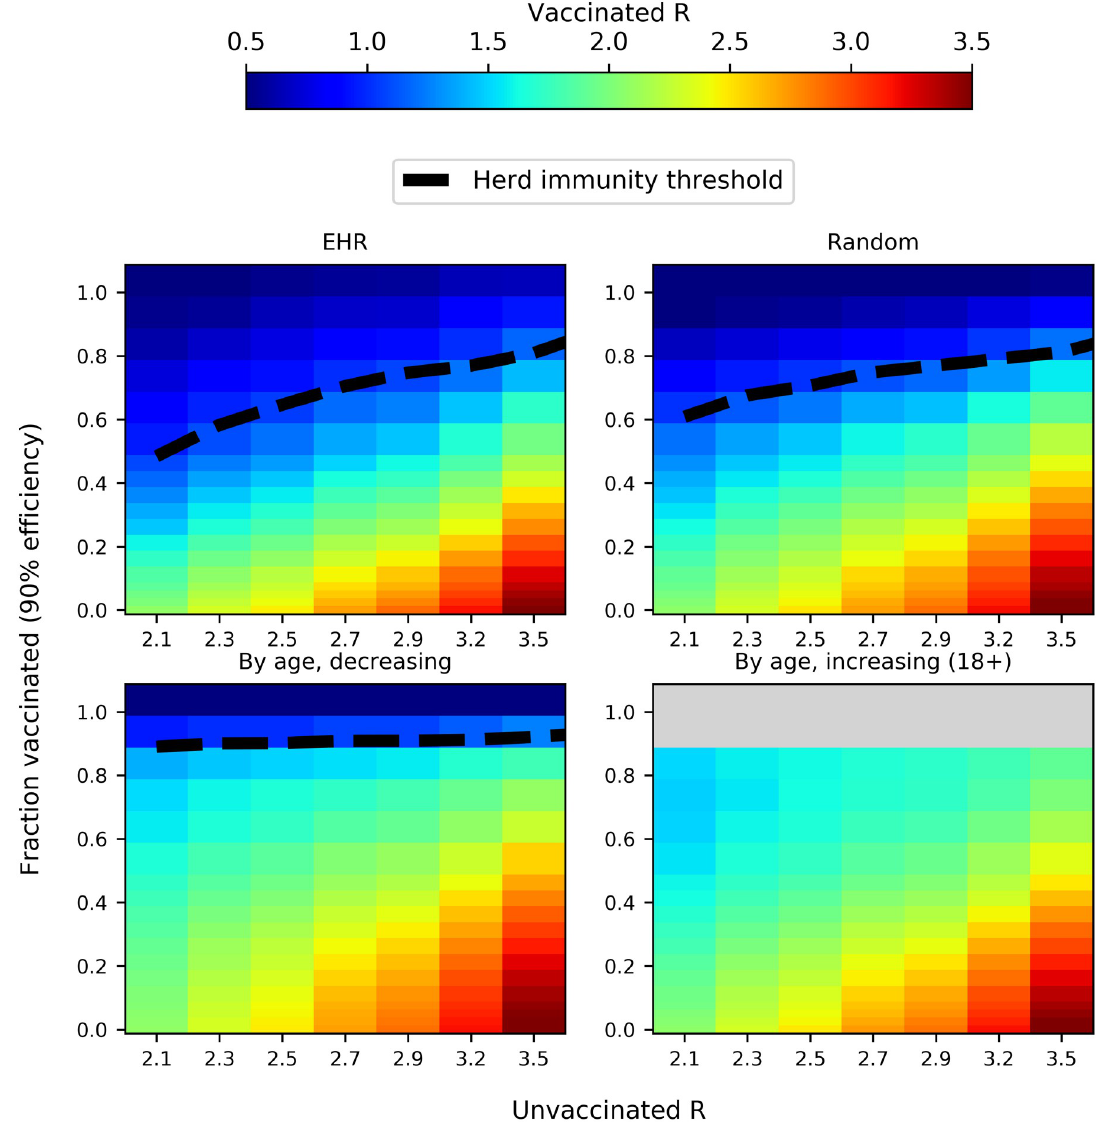
Fig 2. Impact of different vaccination strategies on the reproductive number R according to varying pre-vaccination R 0 . R 0 is adjusted by varying the amount of contact in the random layer of the model, while other layers (schools, workplaces, households) are kept constant. Dashed lines indicate the fraction of population which needs to be vaccinated in order to achieve herd immunity R < 1 depending on R 0 for an unvaccinated population. Herd immunity thresholds are also shown for random and age-dependent vaccination for comparison purposes. Grey denotes infeasible vaccination fractions ( > 80%) for the 18+ strategy. The depicted R values are averages of 20 duplicate simulations for each data